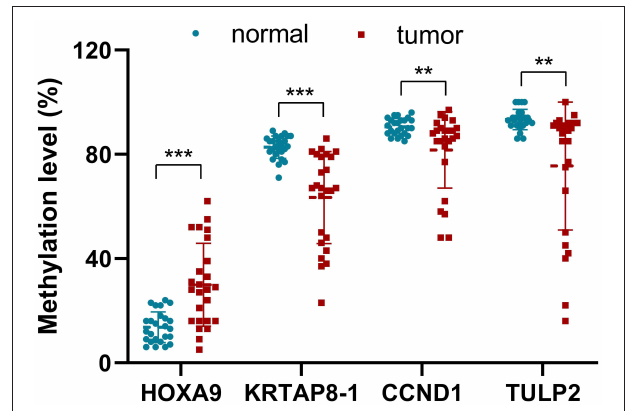
FIGURE 4 | The methylation level (%) for the four selected probes of the tumors and non-malignant samples validated in 25 patients with LUAD using pyrosequencing (** p < 0.001, *** p <